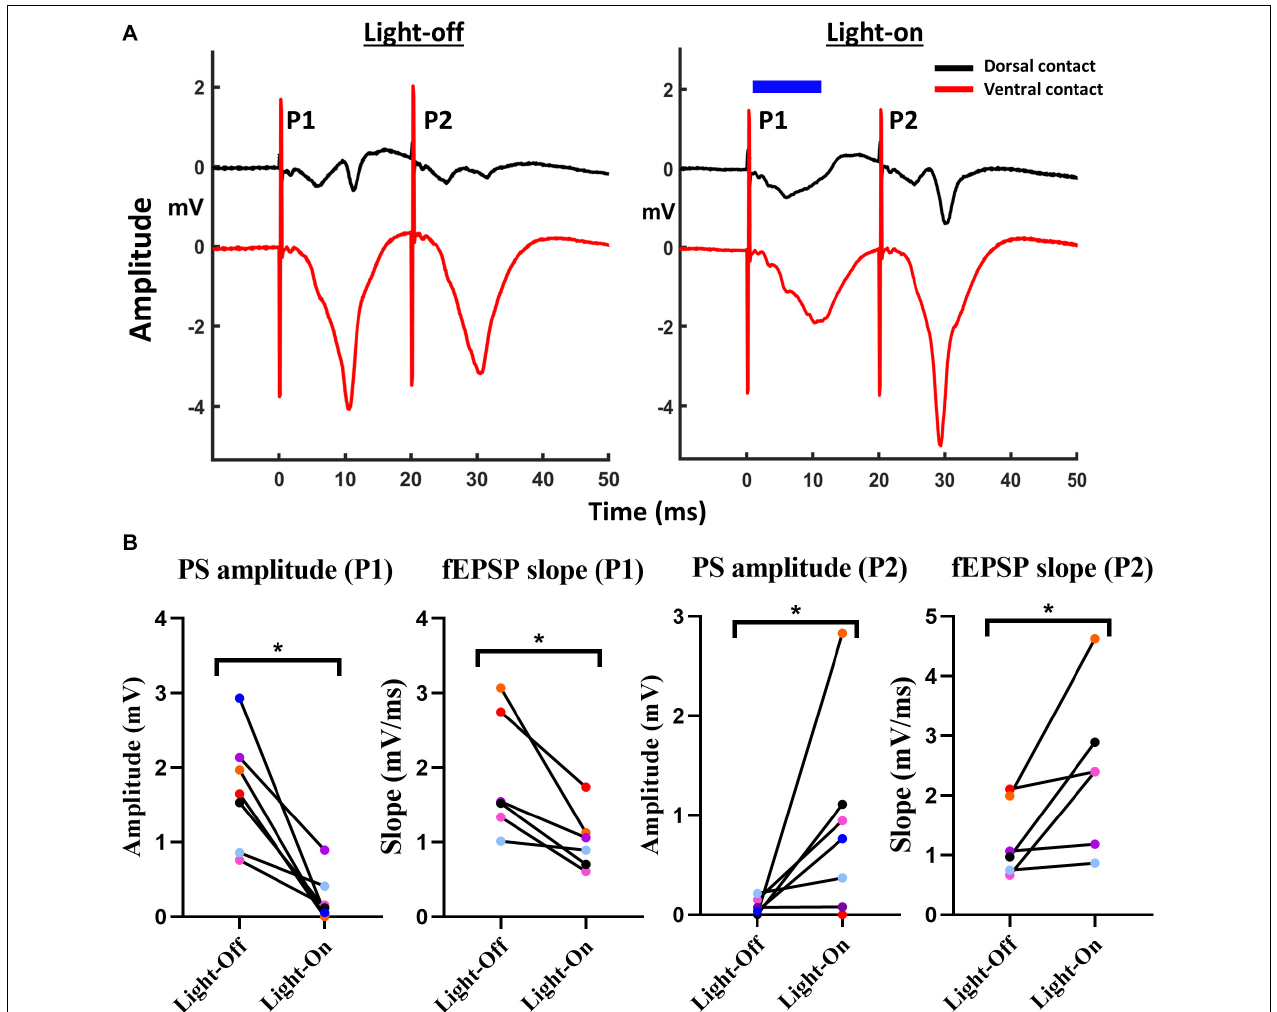
FIGURE 3 | Activation of GtACR2 affected paired-pulse relations of CA1 EPs. (A) Representative traces of paired-pulse CA1 EPs without (red trace) and with (blue trace) delivery of 10 ms light-pulse (blue bar) at 160 mW/mm 2 , 1 ms after the electrical stimulation. (B) Activation of GtACR2 at P1 resulted in the transition from PPD to PPF as indicated by PS amplitude ( n = 7) and fEPSP slope ( n = 6). The graphs represent values of EP parameters for each individual rat for P1 and P2 obtained in light-on versus light-off conditions. * p ≤